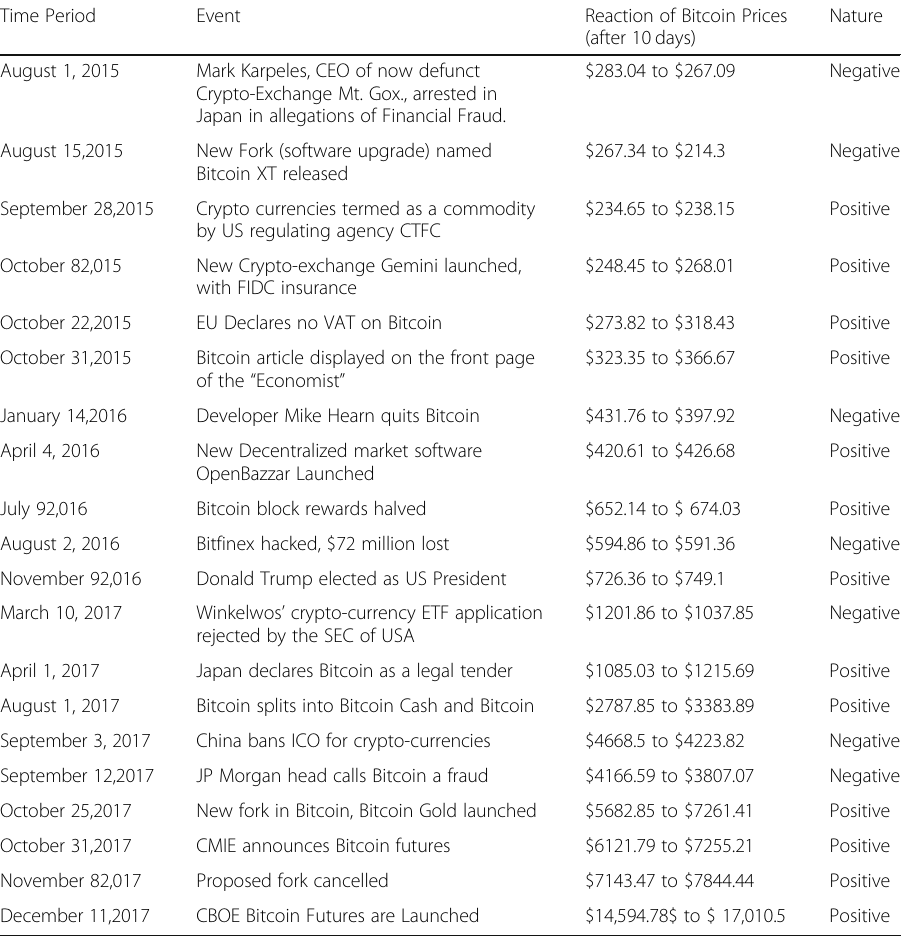
Table 2 Major Events in the Bitcoin